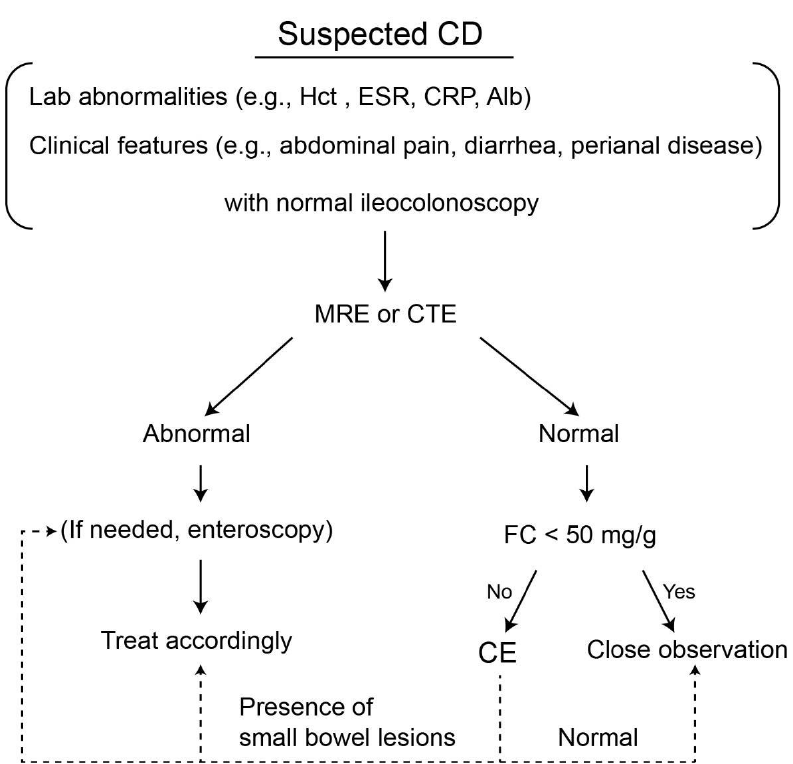
Figure 2. Suggested diagnostic algorithm for the use of small bowel capsule endoscopy in patients with suspected Crohn’s disease. CD, Crohn’s disease; Hct, hematocrit; CRP, C-reactive protein; Alb, albumin; MRE, MR enterography; CTE, CT enterography; FC, fecal calprotectin, CE, capsule endoscopy.